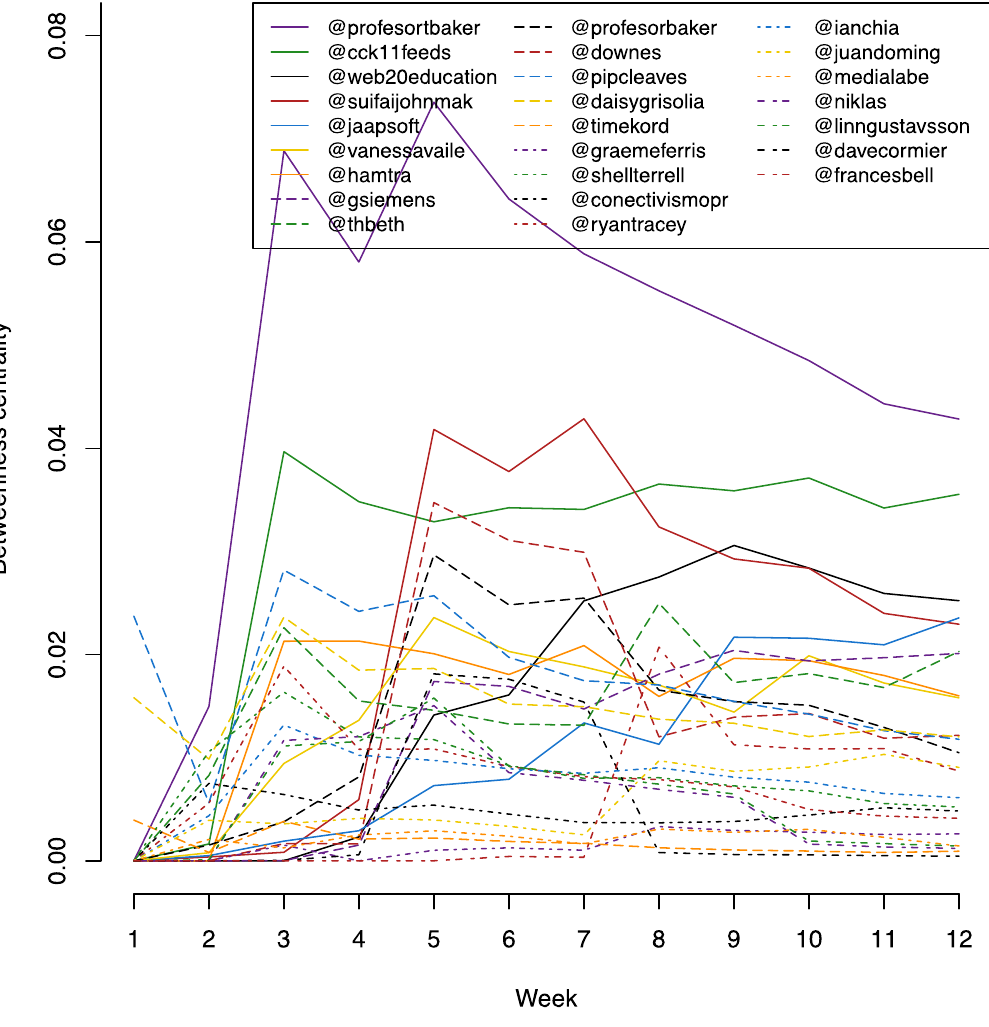
Figure 5. Variation of the betweenness centrality values for the top ranked nodes, over the twelve weeks of the